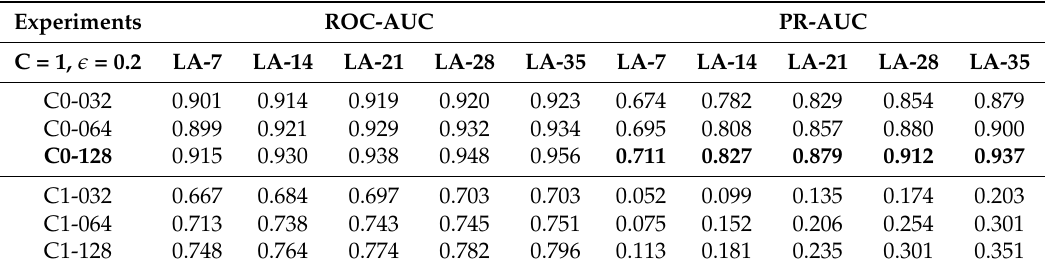
Table 7. ROC and PR C = 1 and (cid:101) = 0.2 as test results of Two Clusters Kmeans in SVR with various timesteps. Experiments